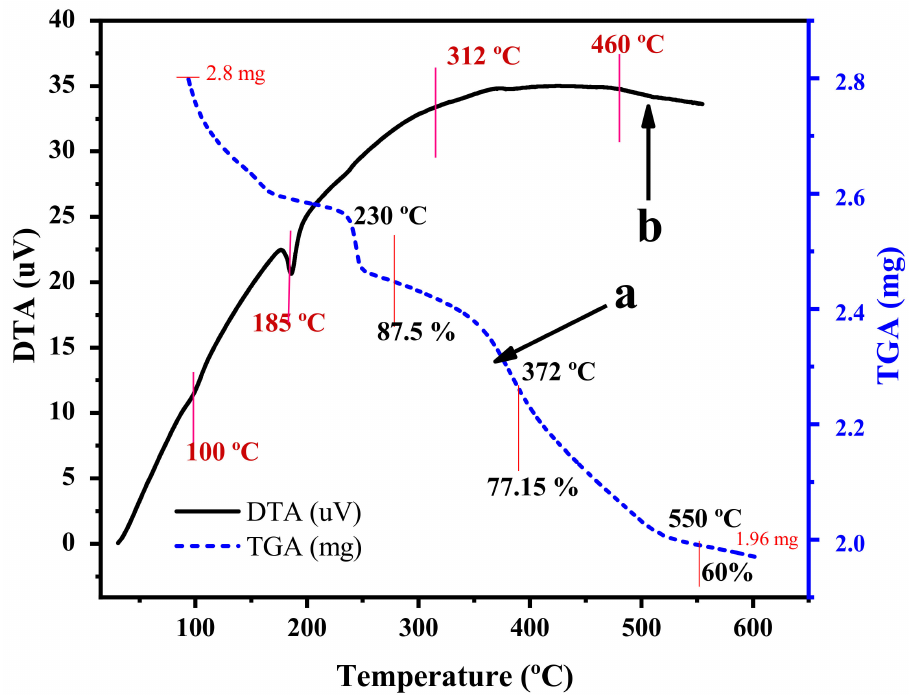
Figure 6. ( a ) Thermogravimetric analysis (TGA) and ( b ) differential thermal analysis (DTA) of Mn 2+ :ZnS